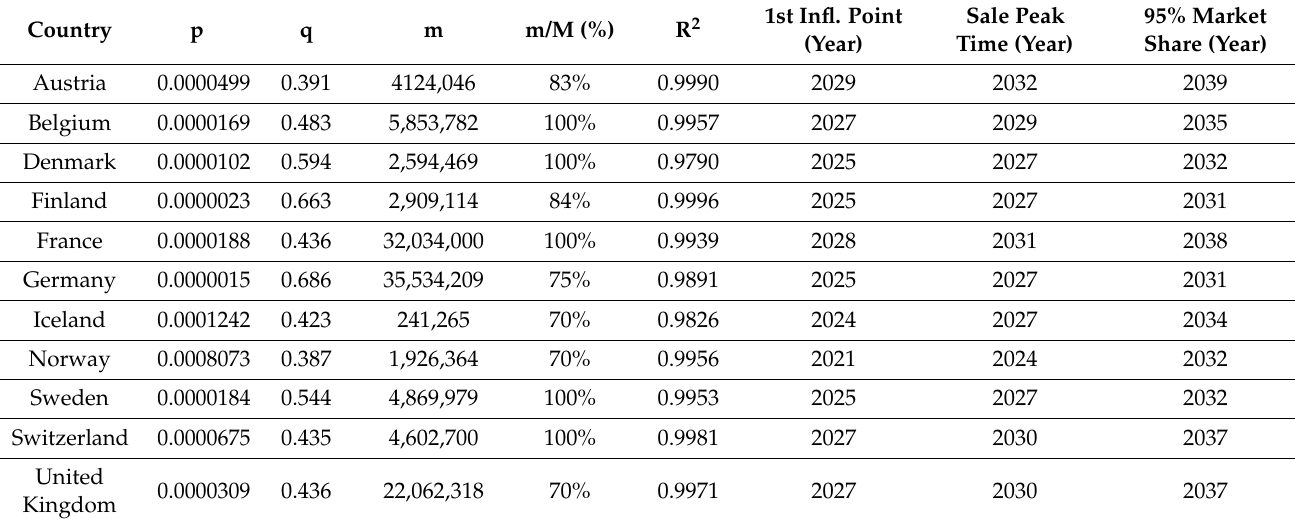
Table 2. Results of model parameters estimation for individual countries from group A (parameters medians from 1000 calls of the NLS method with different initial conditions for each country) [own